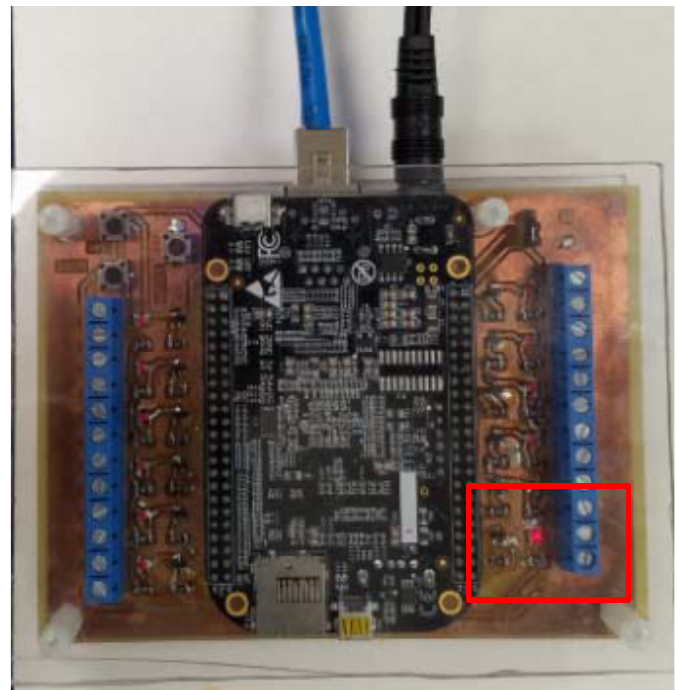
Figure 10. Subscribing IED Processing Fake Message (output port triggered as indicated in the red box).